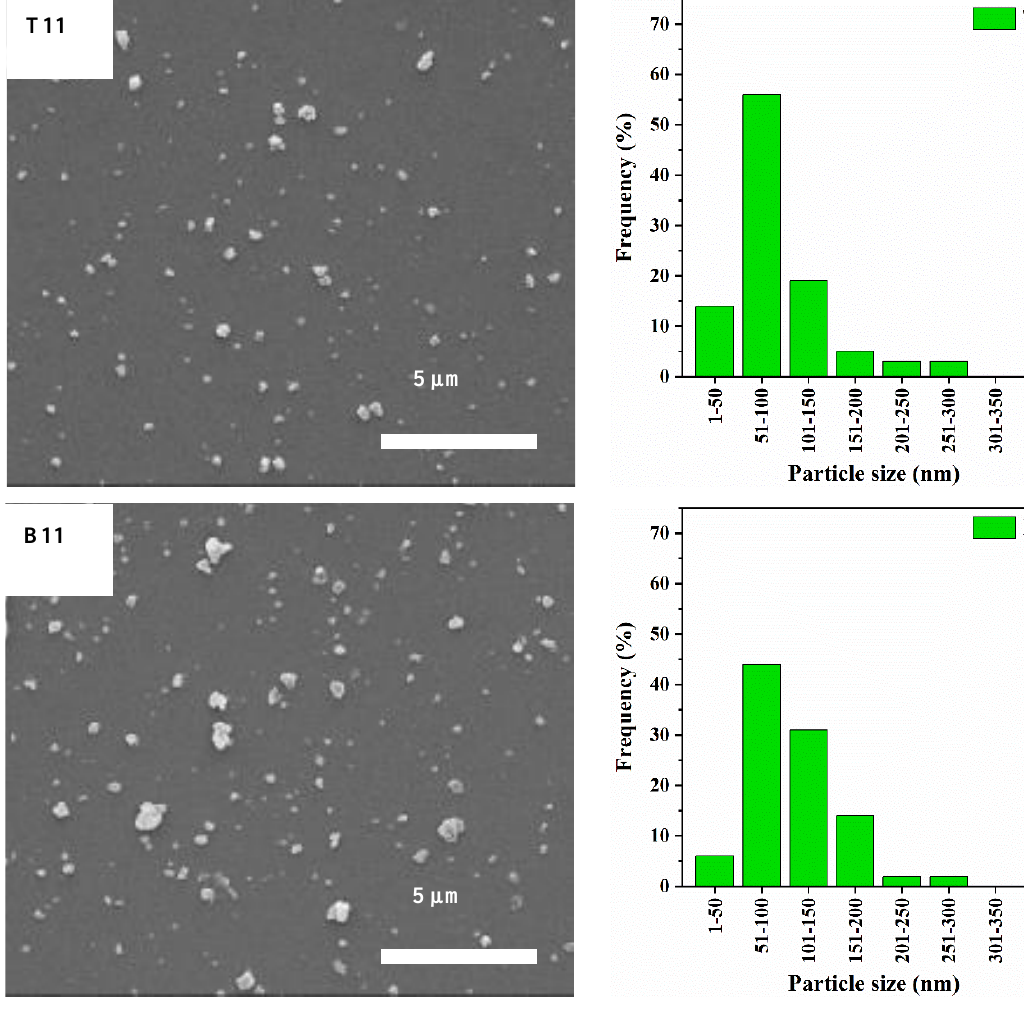
Figure 6. SEM images (left) and particle size distribution (right) of the ball-milled sample of zeolite Y: CNF = 1:1